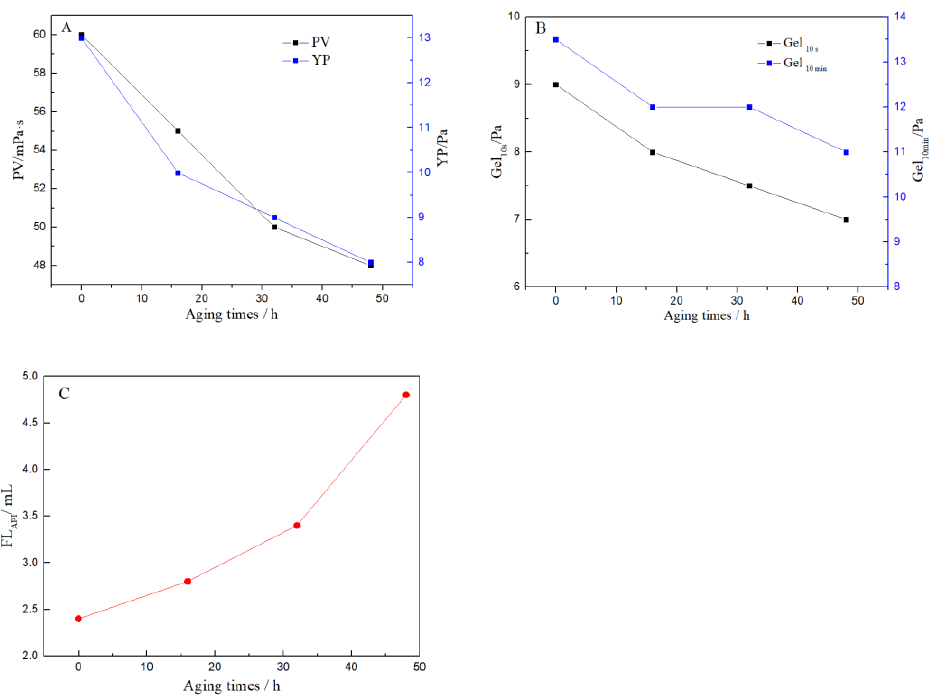
Figure 11. Effect of aging times on the drilling fluid: ( A ) Plastic viscosity (PV) and Yield point (YP), ( B ) The initial gel strength (Gel 10 s ) and 10-min gel strength (Gel 10 min ), ( C ) FL API of the drilling